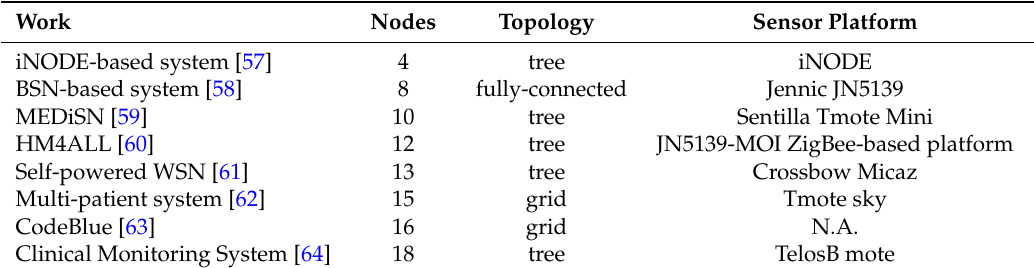
Table 2. Analysis of some WSN healthcare